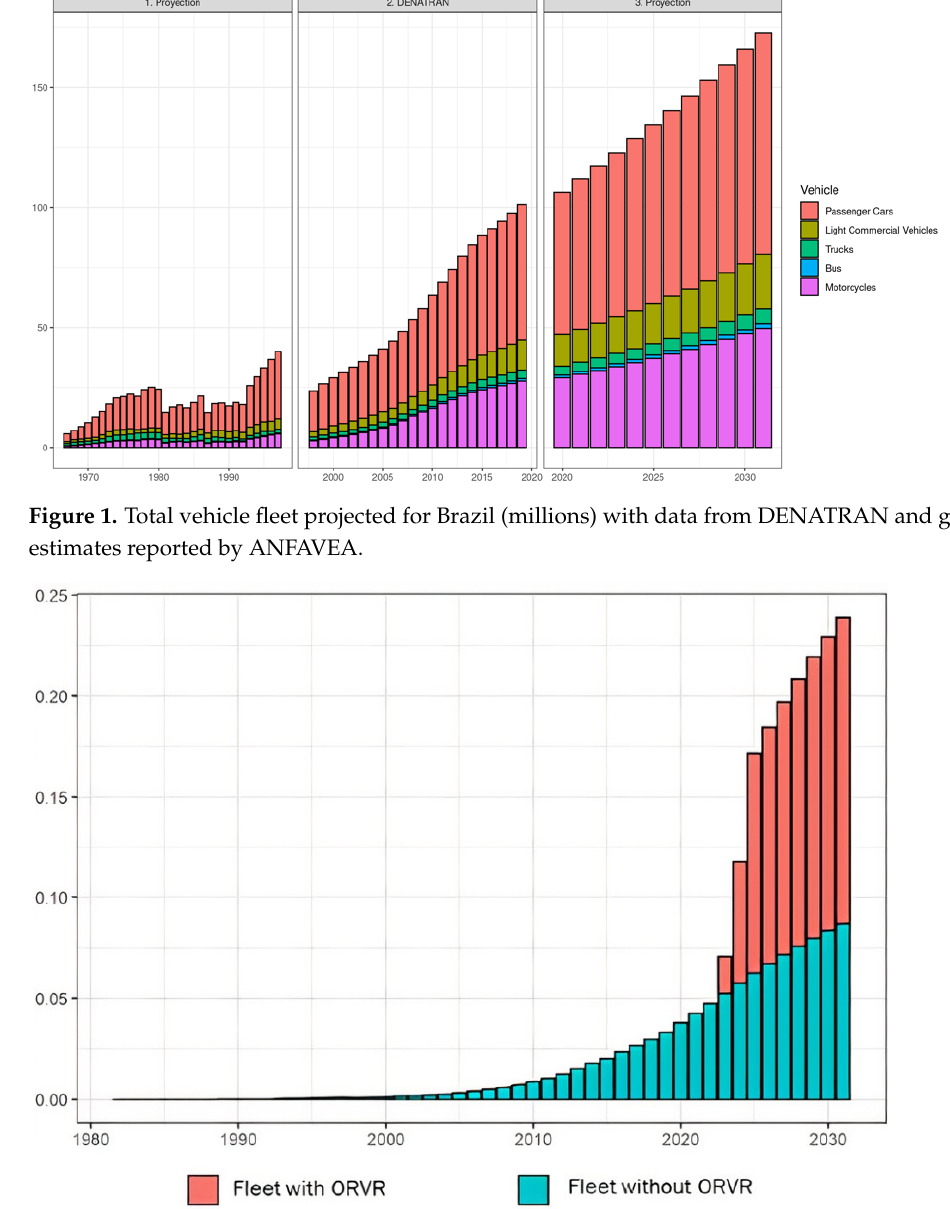
Figure 2. Fraction of the fleet of light vehicles in circulation (excluding scrapped vehicles) with and without ORVR in the year 2031.